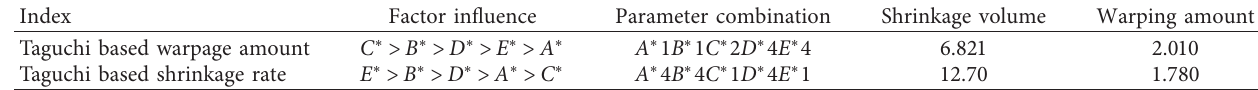
Table 6: Final result of warpage and shrinkage amount based on Taguchi orthogonal